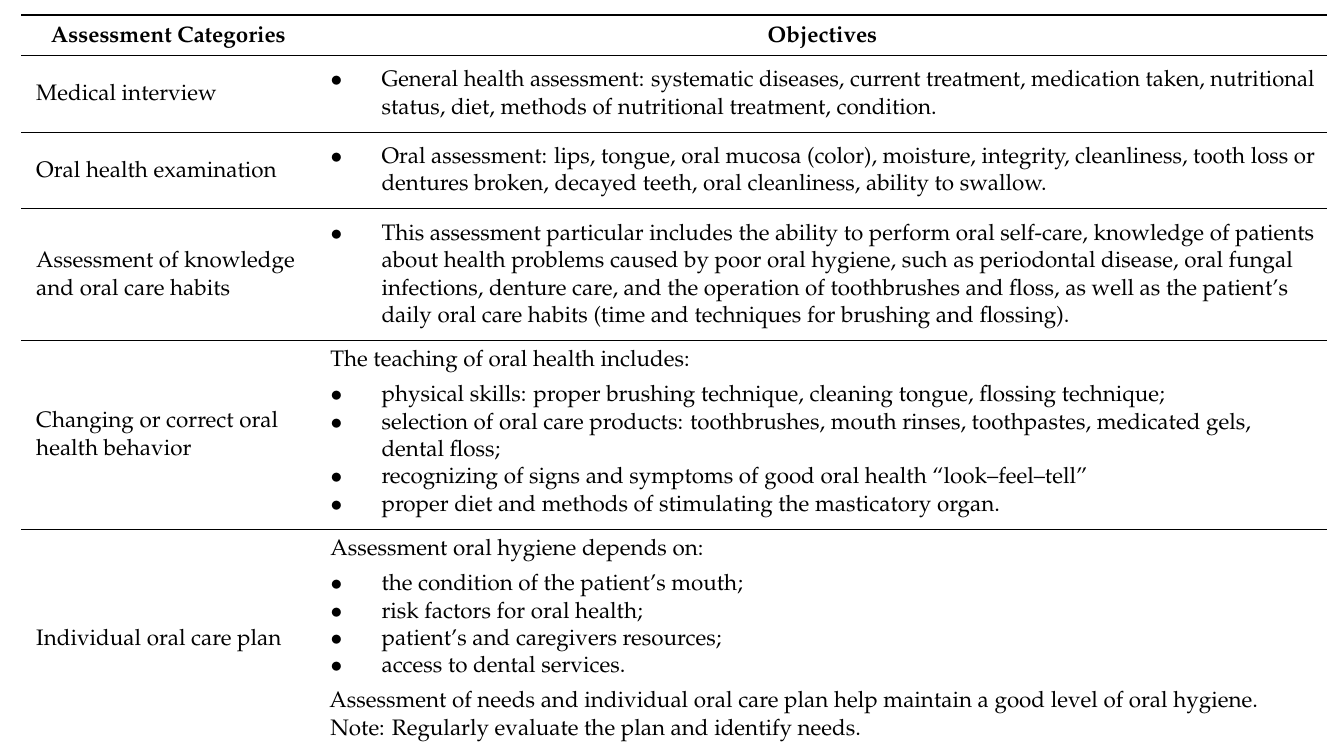
Table 3. Elements of a comprehensive oral assessment in a nursing care